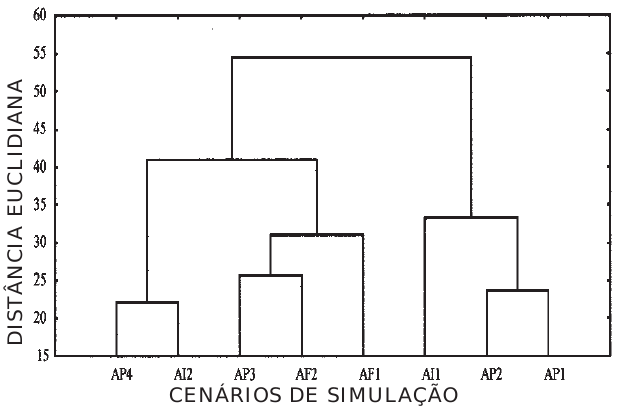
Figura 3. Análise de agrupamentos - distância euclidiana - considerando os diversos cenários de